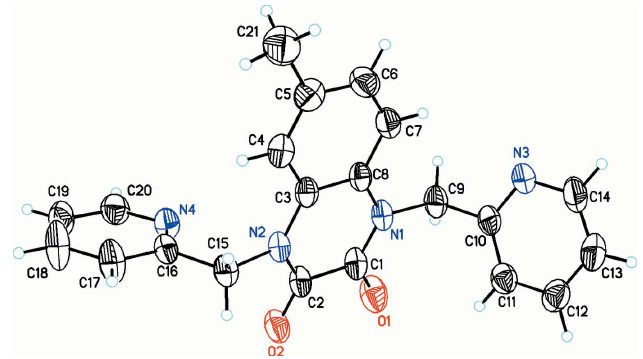
Figure 1 The molecular structure of the title compound, shown with 30% probability displacement